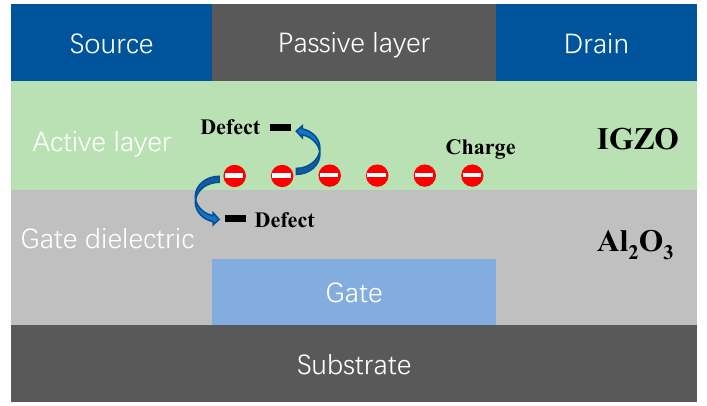
Figure 1. Illustration of carrier trapping process in CAAC-IGZO FET. The hybrid functional of Heyd-Scuseria-Ernzerhof (HSE06) was used to ensure the ac- curacy of bandgap calculation and avoid the small bandgap under GGA-PBE function [23]. 30% and 15% of PBE were replaced with Hartree-Fock function in the calculation of Al 2 O